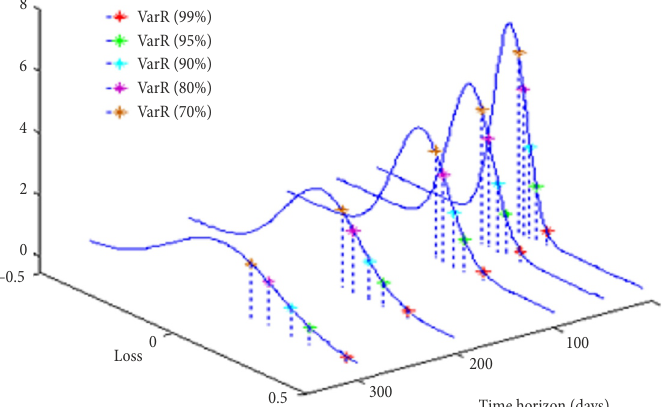
Fig. 1. Representation of the measure VaR in dependence of trust threshold and time